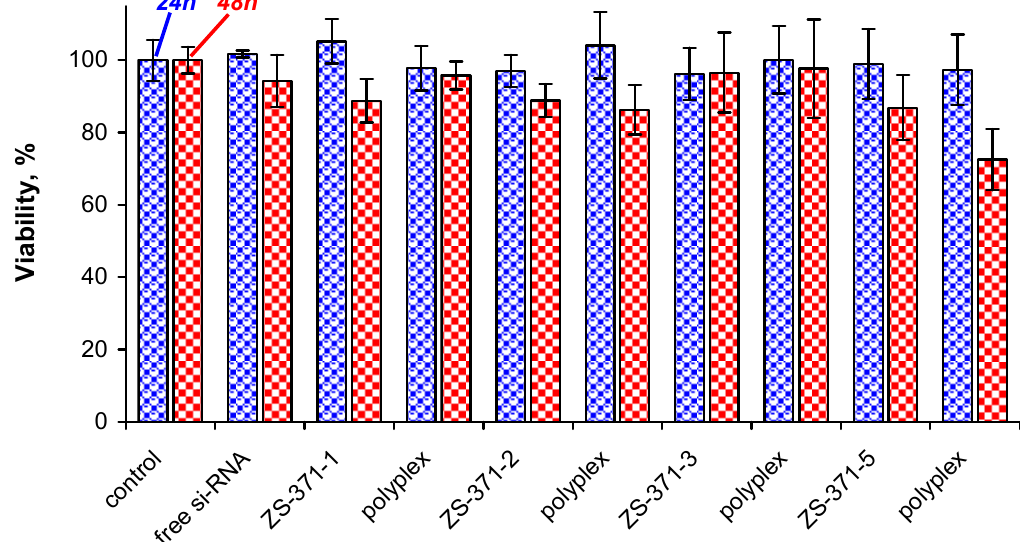
Figure 7. Cell viability of A549 cancer cells after treatment with different polymers both independently as well as after complexation with anti-VEGF si-RNA. Data represent mean ± SD (* p < 0.05, n = 5).